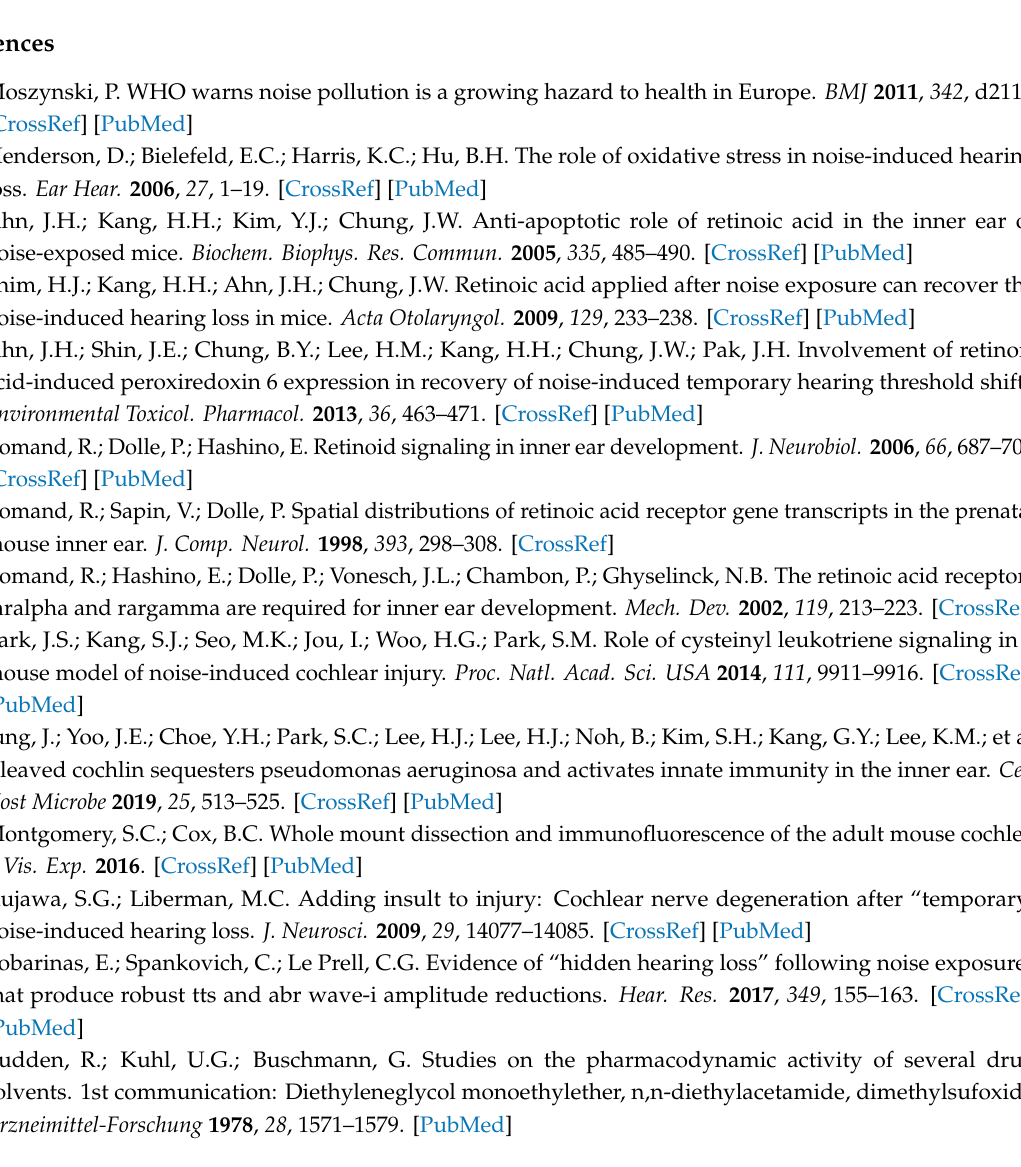
Figure S1: Data from placebo group with water ( n = 3) was compared with that from placebo group with DMSO ( n = 3). A. in post-noise day 7, wave I amplitude in auditory brainstem response (ABR) did not di ff er between two groups. B. ABR threshold by click stimuli after noise exposure were not significantly di ff erent between two groups over